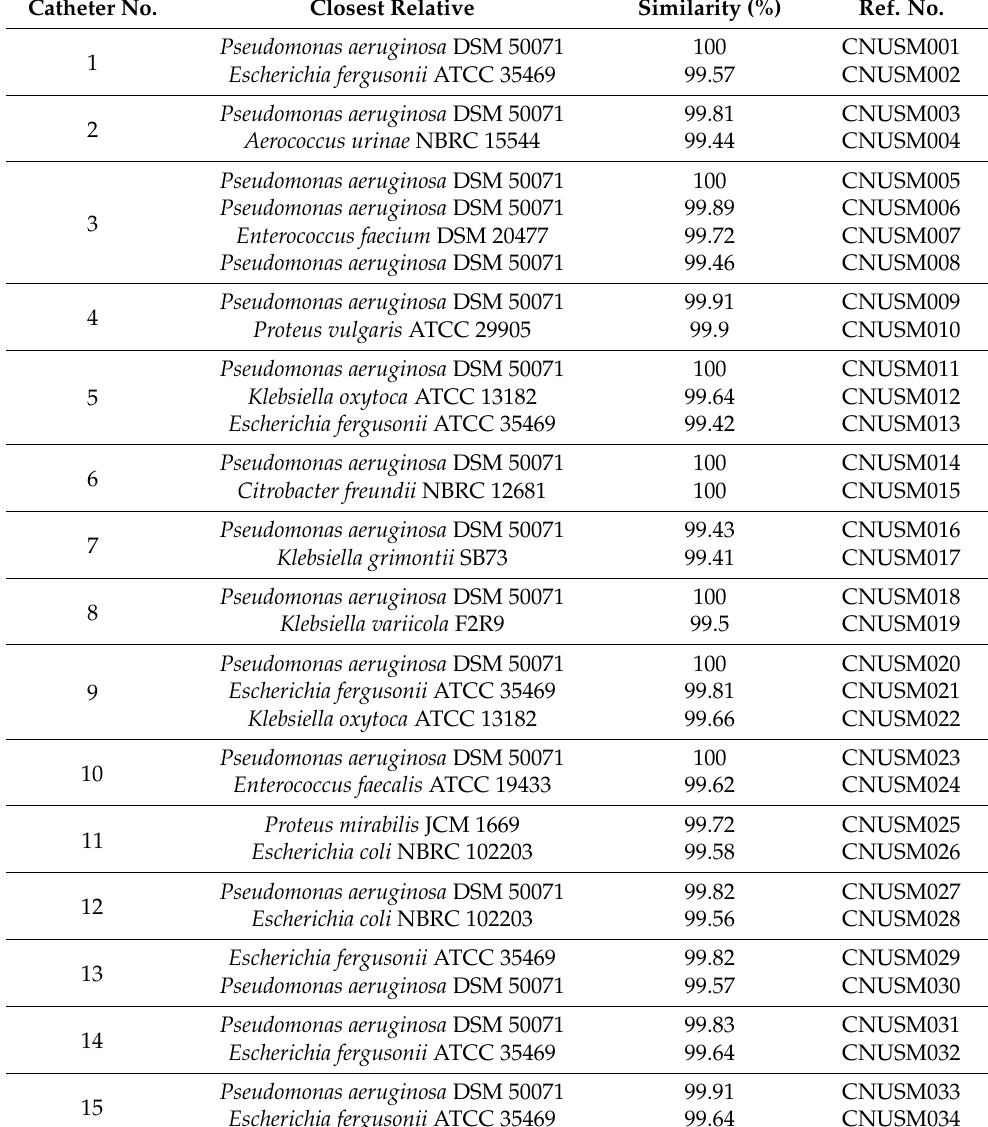
Table 1. Closest relatives of the isolates from indwelled catheters based on 16S rRNA gene sequencing. Catheter No. Closest Relative Similarity (%) Ref.